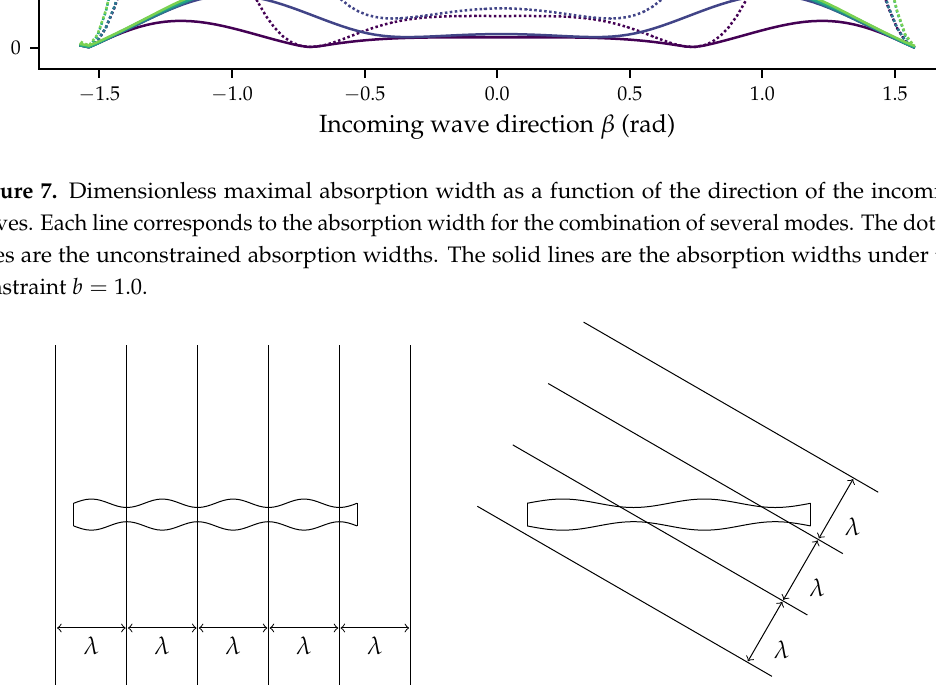
Figure 8. A wave with wavelength λ propagating in the direction of the cylinder is exciting the mode of wavelength λ . When the same wavelength is propagating with an angle β with respect to the cylinder, it can excite a mode of wavelength λ / cos ( β )